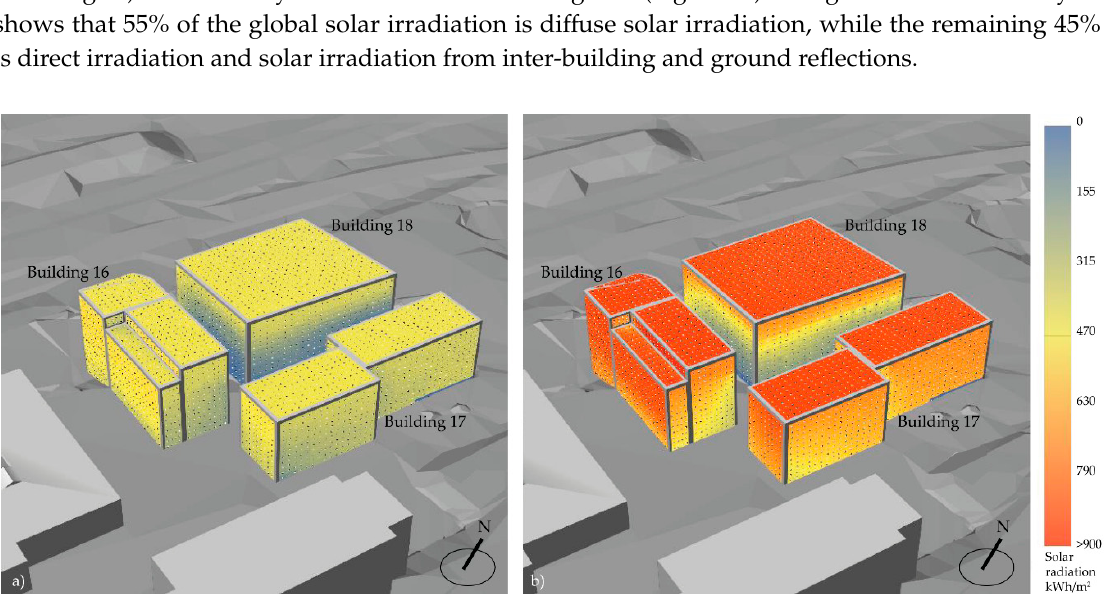
Figure 16. Annual analysis of direct solar irradiation ( a ) and global irradiation analysis ( b ) in the critical area in the existing situation.